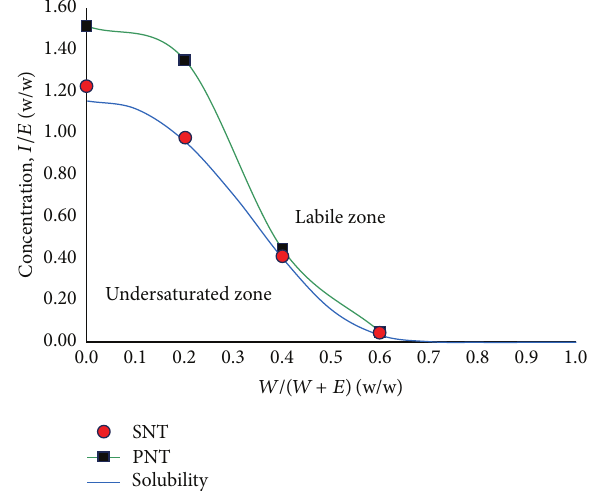
Figure 13: Phase diagram for ibuprofen in water-ethanol mixtures with superimposed SNT and PNT data at 25 ∘